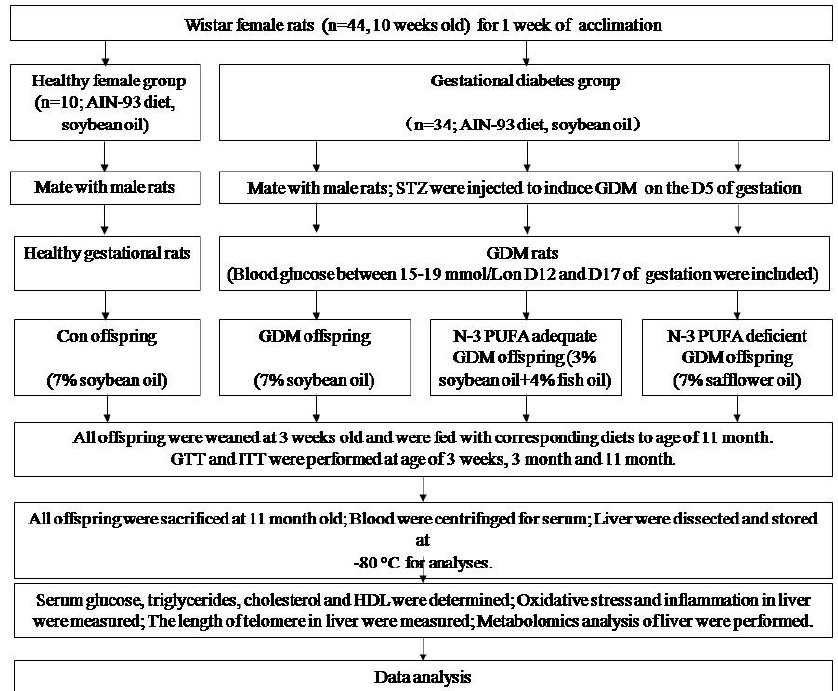
Figure 1. Flow diagram showing the protocol of the study.